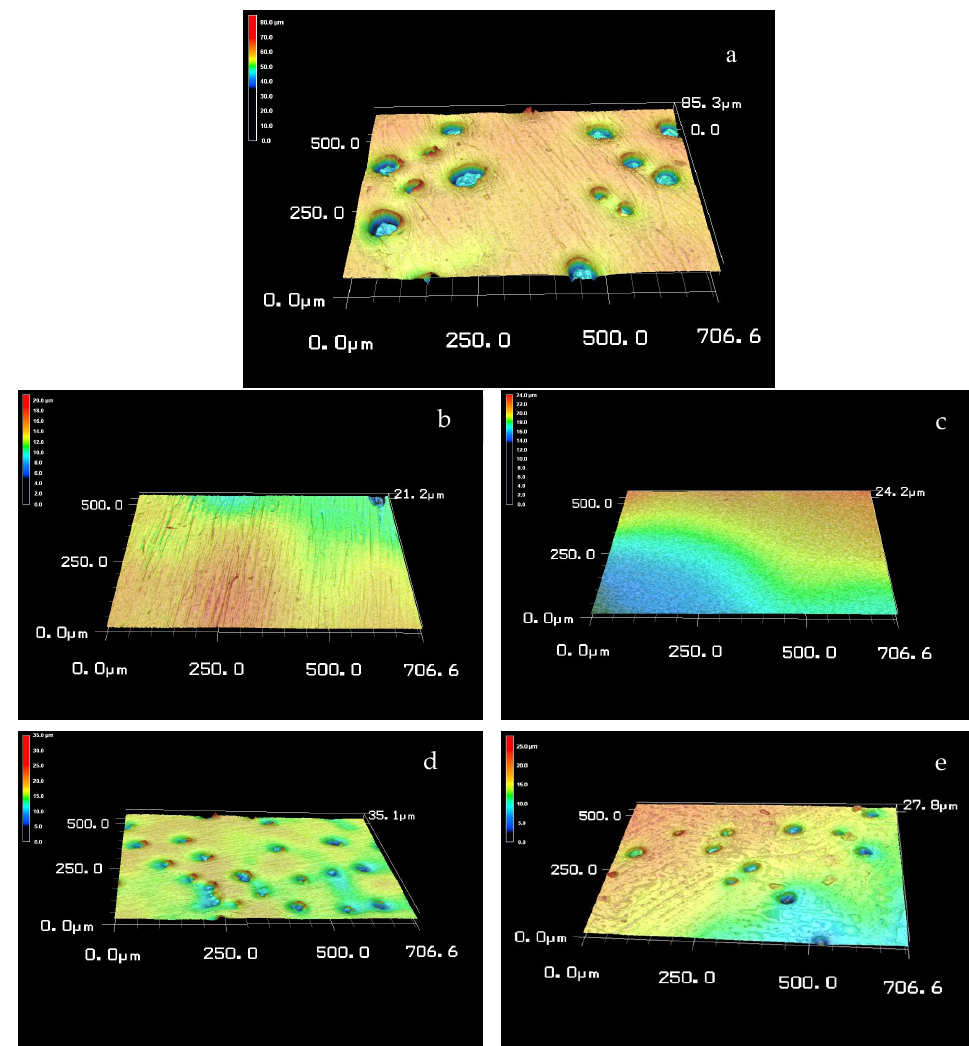
Figure 1. Three-dimensional images of chairside CAD/CAM reinforced lithium disilicate ceramic; ( a ) non-polished; ( b ) polished with Dialite ceramic polishing; ( c ) polished with OptraFine ceramic polishing; ( d ) polished with Diacomp composite polishing; ( e ) polished with Astropol composite